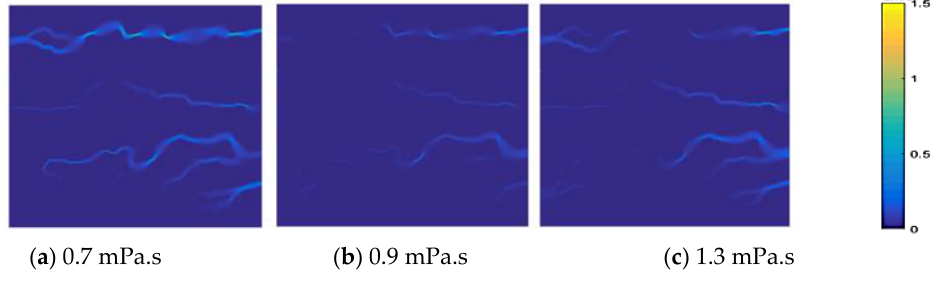
Figure 22. Simulation results under different oil phase viscosities.